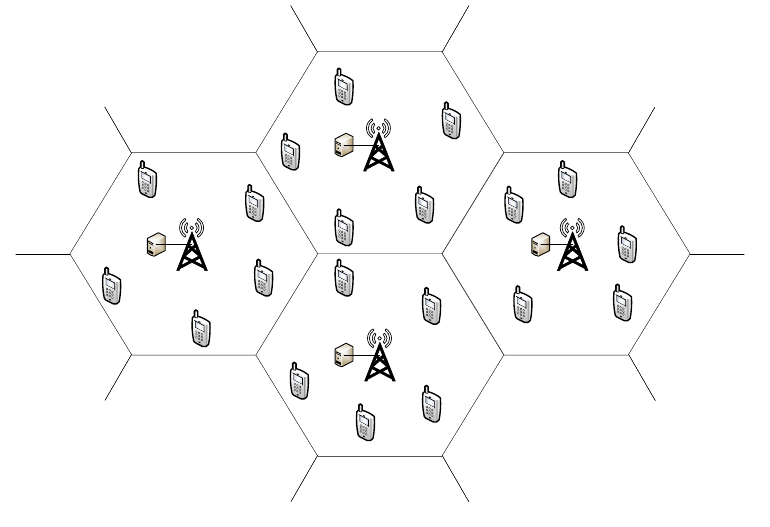
Figure 1. Wireless